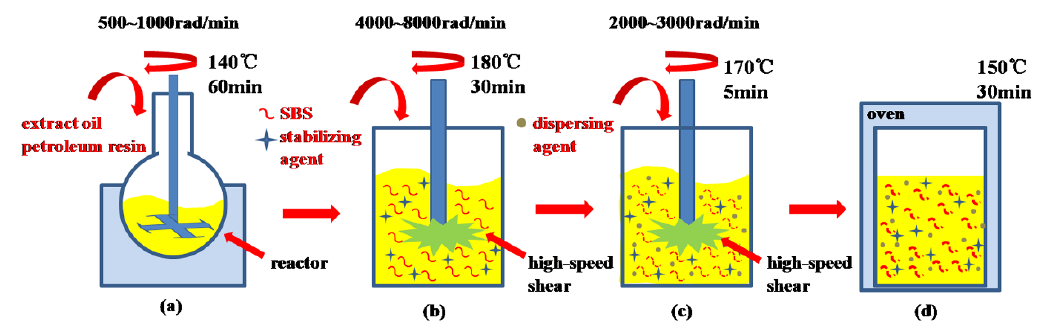
Figure 2. Preparation process of the polymer-modified rejuvenators: (a) blending the extracted oil and petroleum resin in reactor; (b) adding SBS modifier and stabilizing agent in high speed shearing machine; (c) adding dispersing agent in high speed shearing machine; (d) keeping the samples in oven.